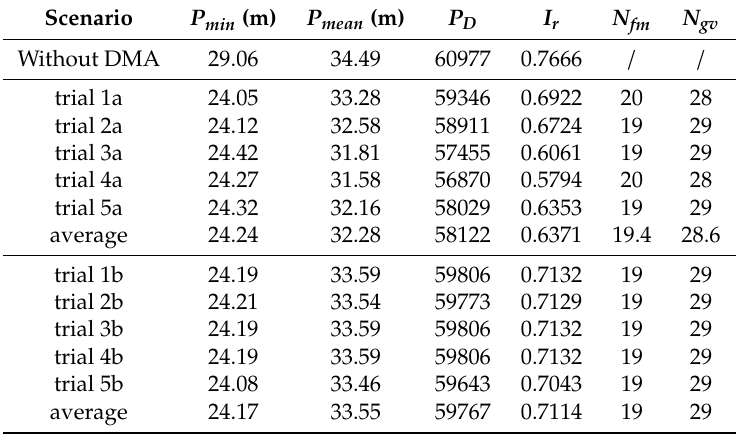
Table 6. Performance comparison of 10 trials ( OF3